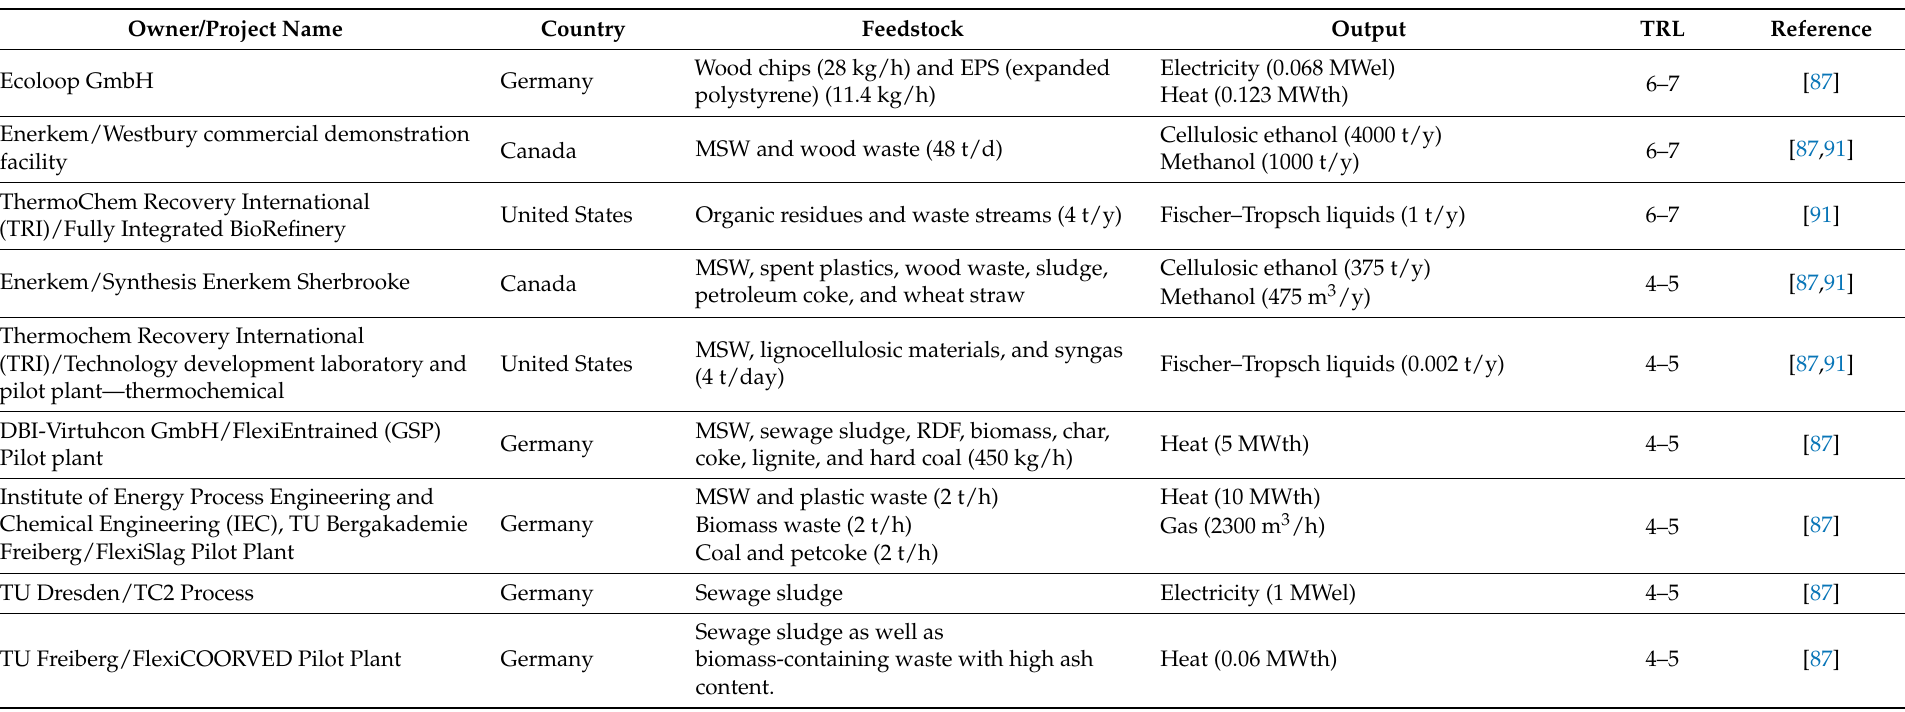
Table 6. Waste gasification projects with lower